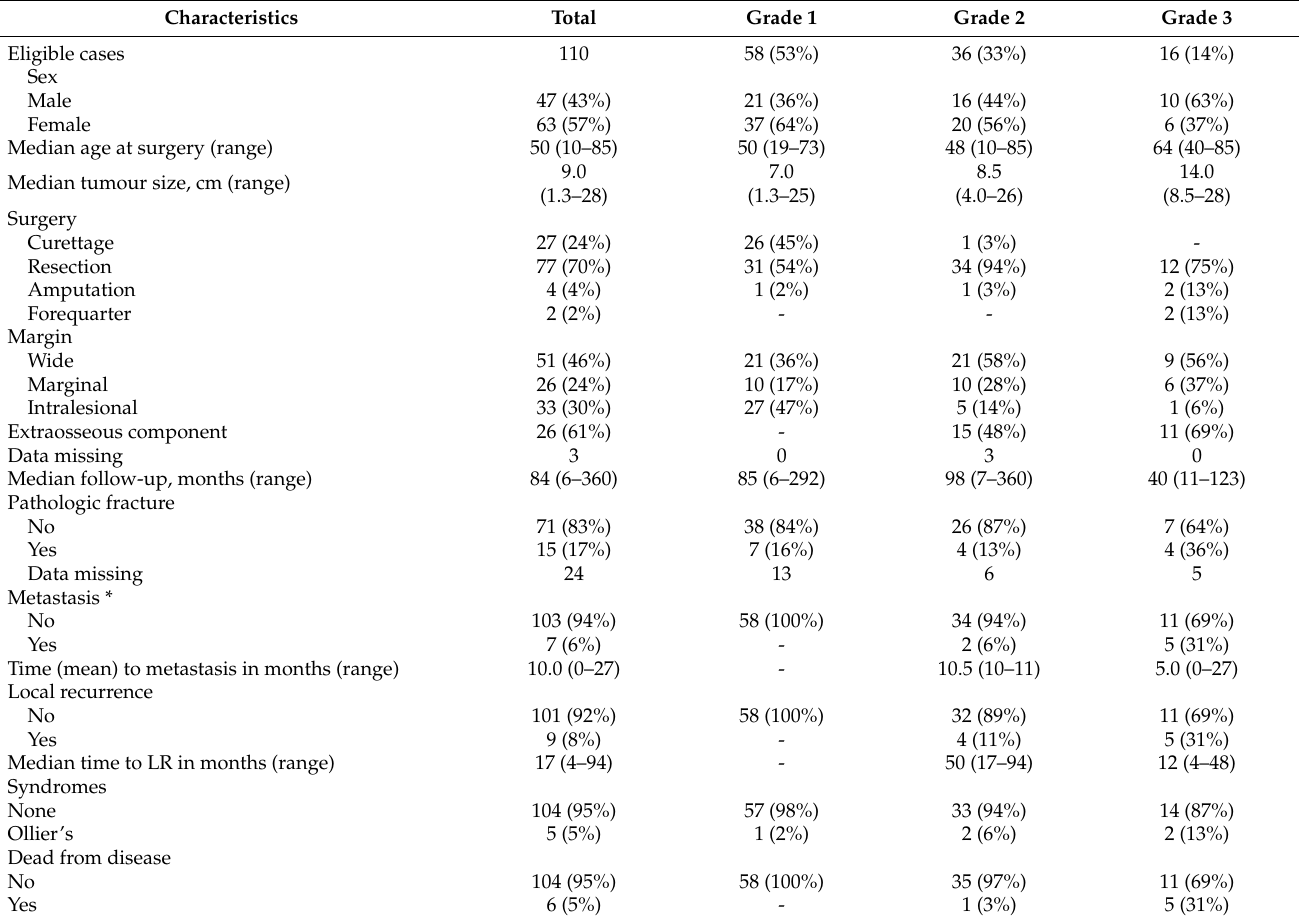
Table 1. Characteristics of 110 proximal humerus central conventional chondrosarcoma cases (values are presented as number of